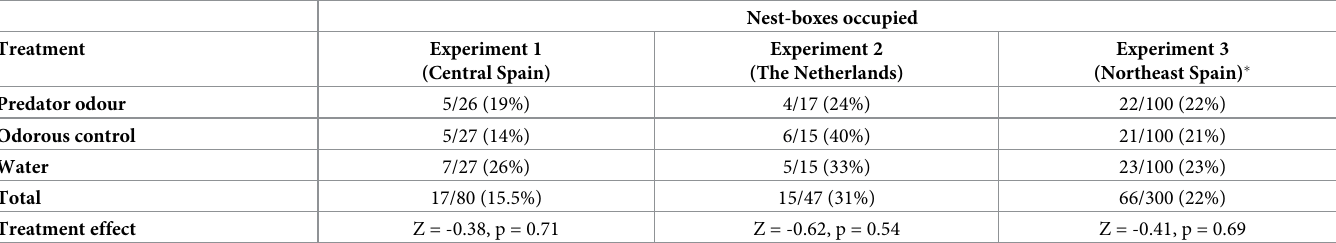
Table 1. Number of nest-boxes used for roosting/number of nest-boxes with the correspondent treatment (and the percentage of used nest-boxes) when the nest- boxes contained predator scent (mustelid), a pungent odorous control or water in three experiments aimed to analyse whether birds avoid roosting in nest-boxes containing predator chemical cues.